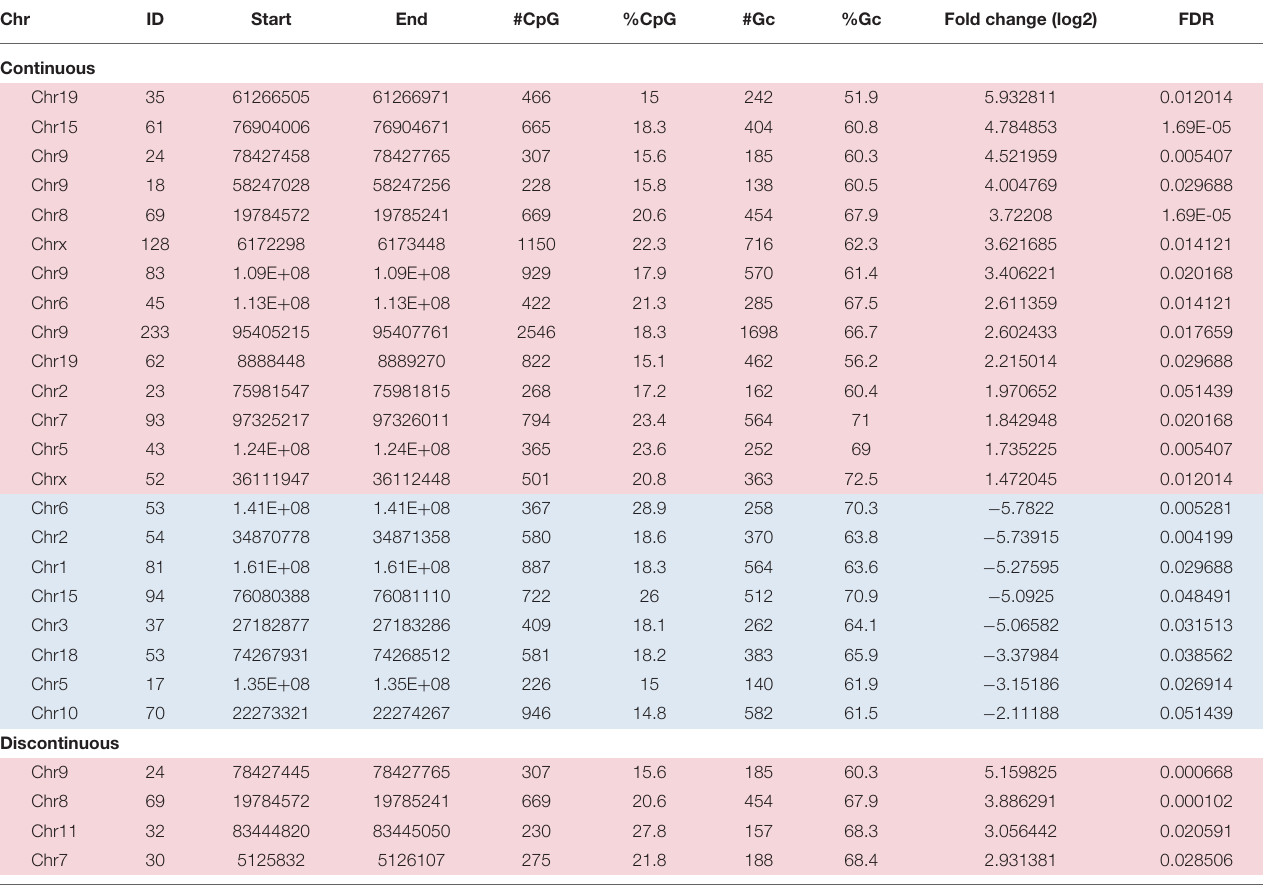
TABLE 1 | DMRs in CpG